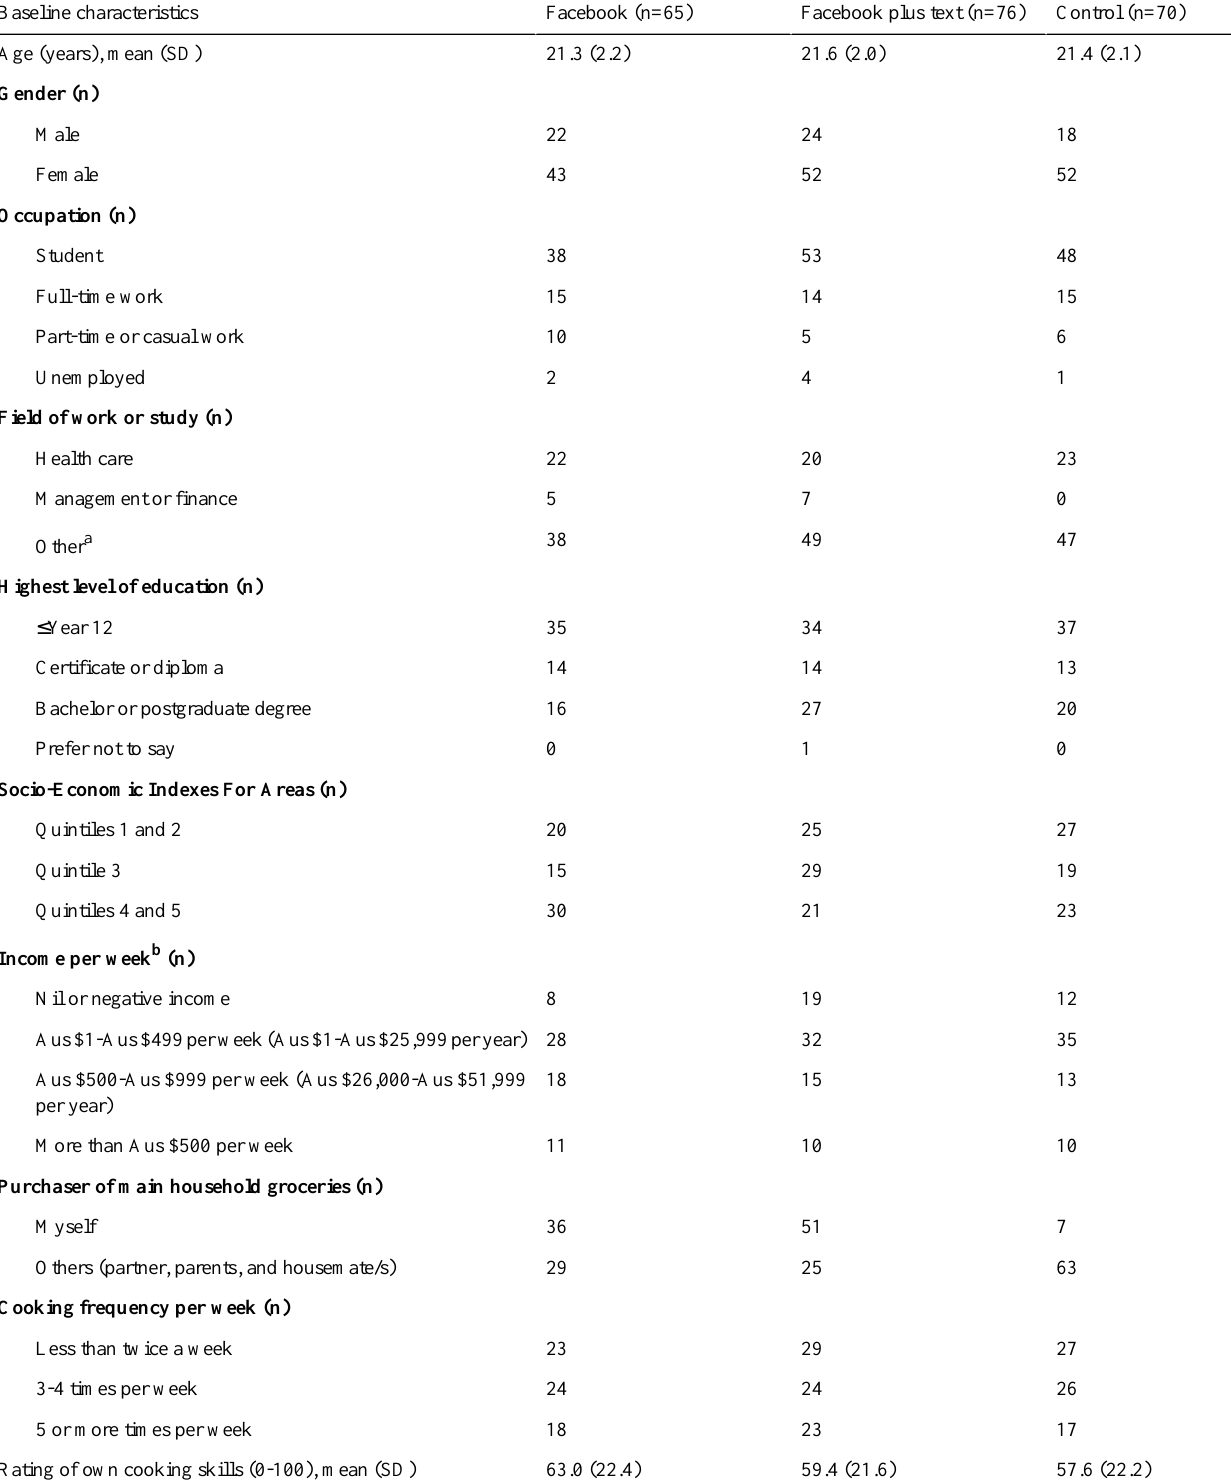
Table 2. Demographics of participants from the CAlcium Nutrition-Dietary Opportunities